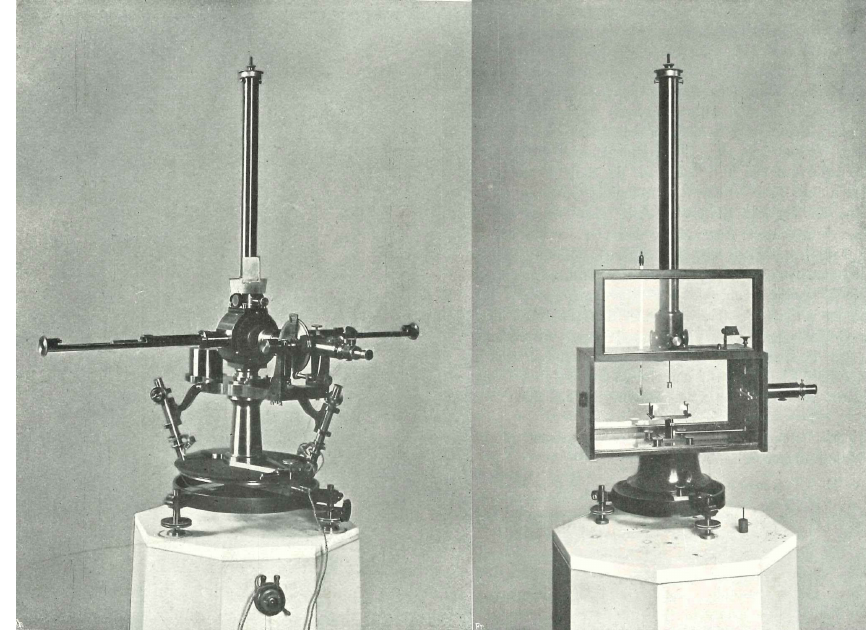
Figure 5. Magnetic theodolite (left) and oscillation box (right) made by Wanschaff, Berlin. Source: Hellmann